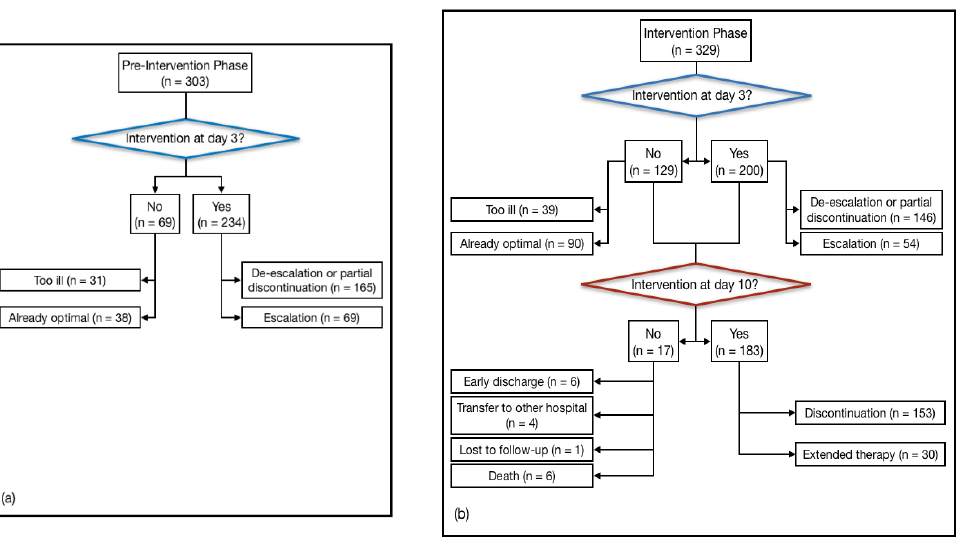
Figure 1. Flow diagram of interventions at day 3 and day 10 in the two study periods. Type and number of interventions implemented in the pre-IP and IP are shown respectively in (a) and (b).